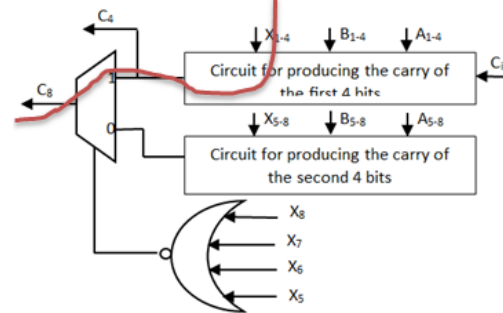
Figure 11. CPD of figure 7.